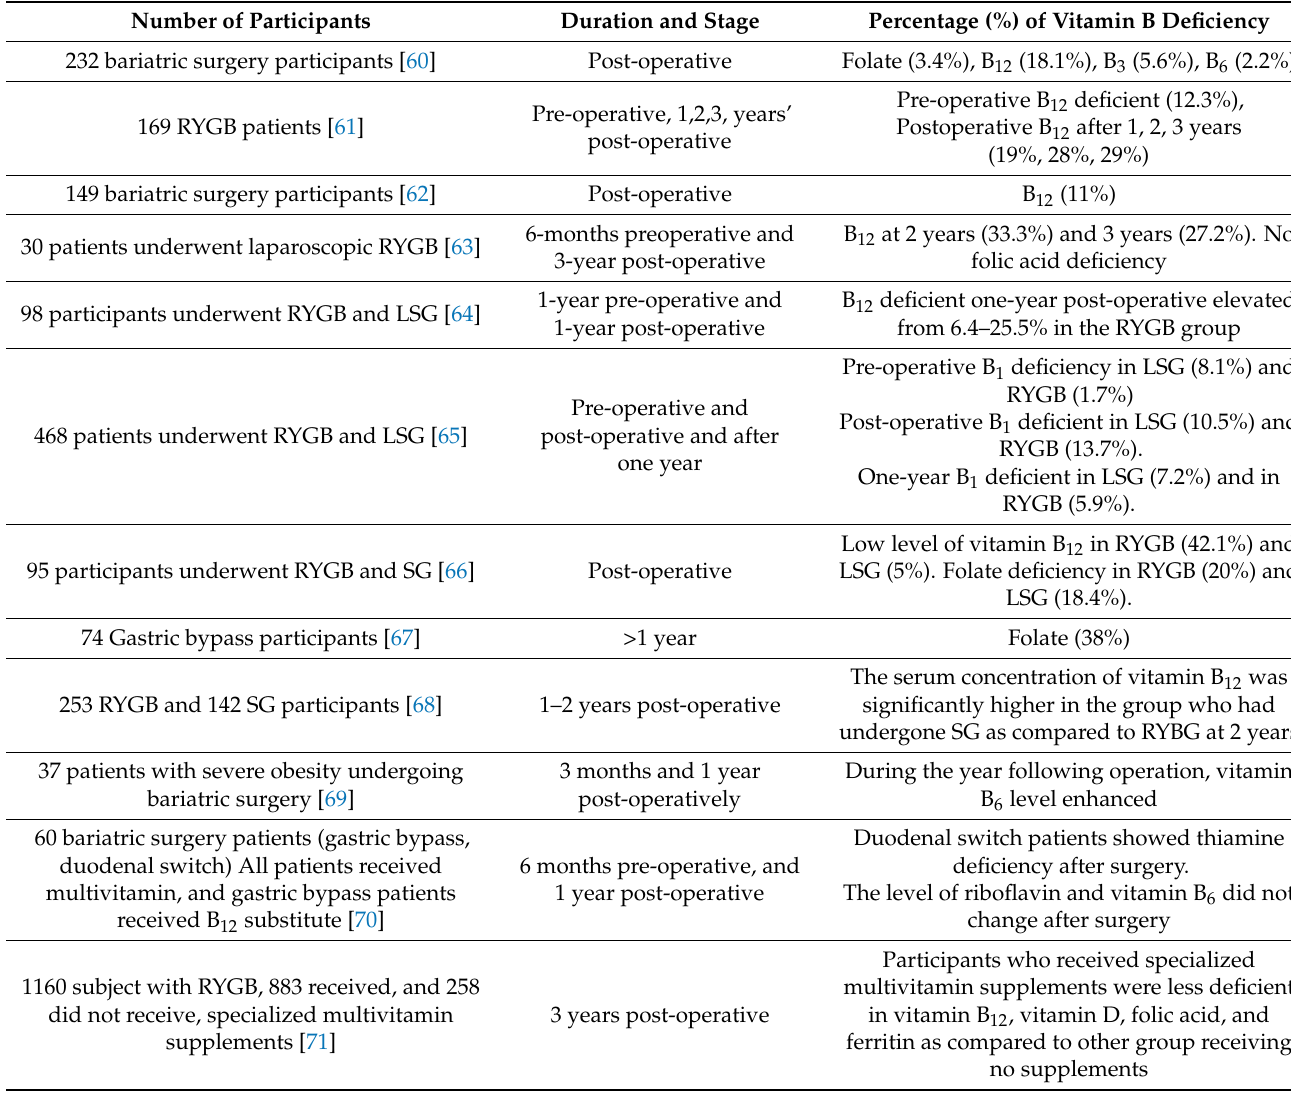
Table 2. Percentage of vitamin B deficiency in bariatric